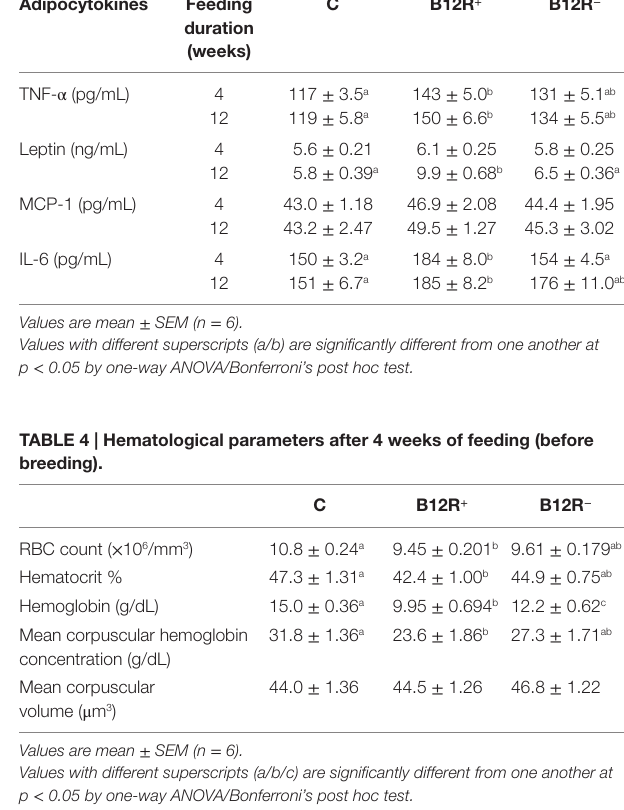
adipocytokines Feeding